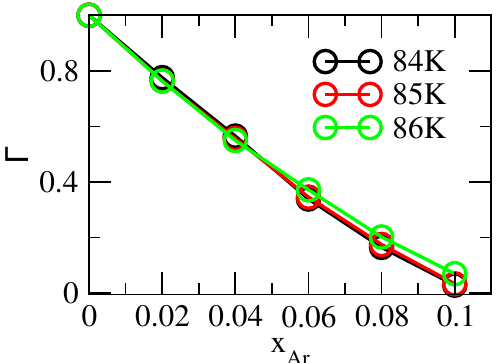
Figure 7. Thermodynamic correction factor as a function of Ar